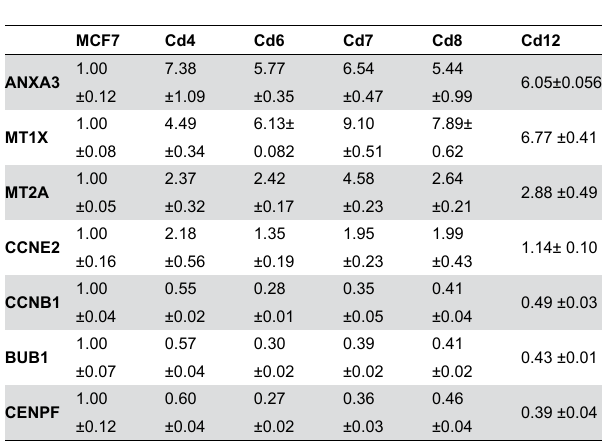
Table 6. Summary of Gene Expression Fold Changes.